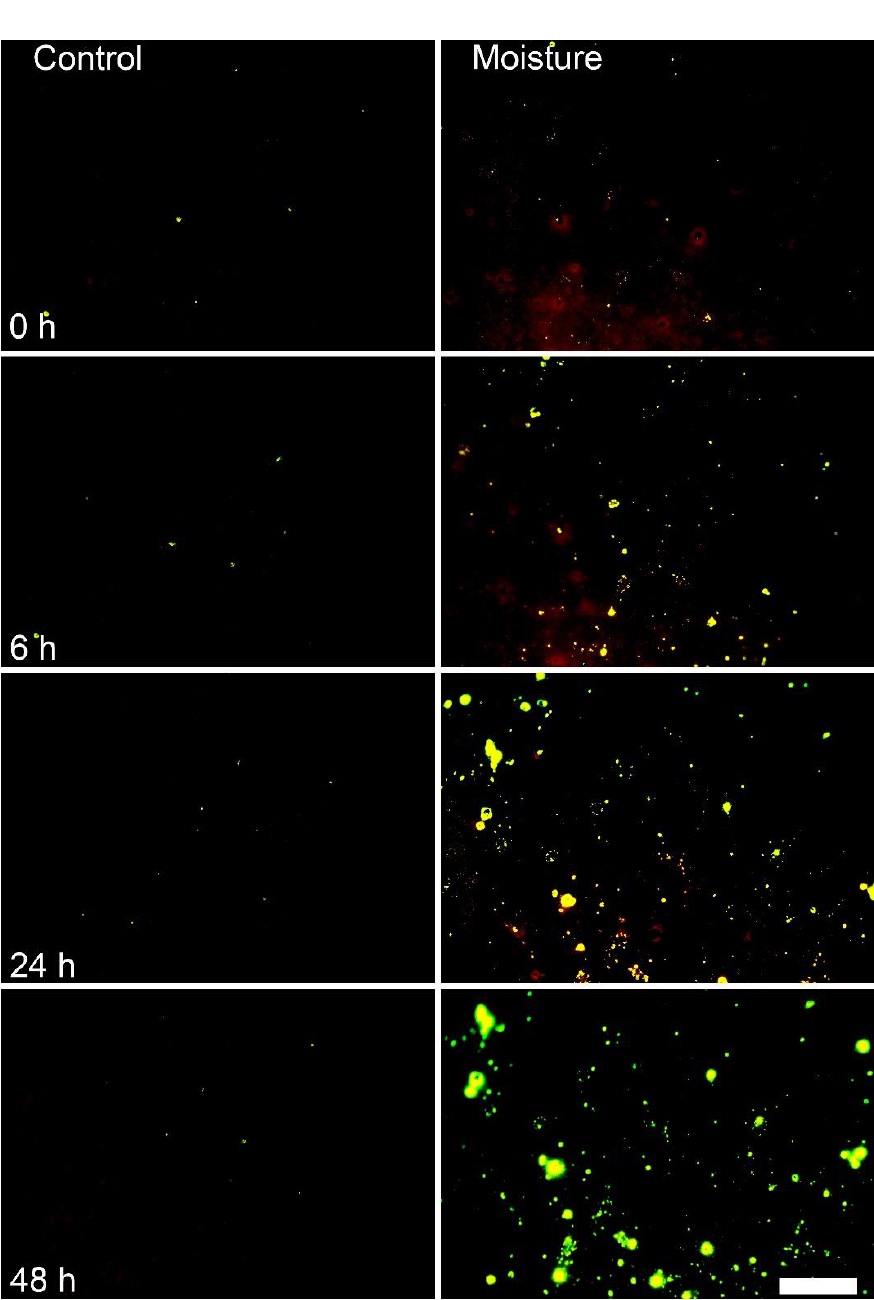
Figure 1. Effect of moisture exposure of the surface of fruit of mango cv. apple on microcracking of the cuticle. The fruit surface was exposed to surface moisture for 0, 6, 24 or 48 h. An untreated surface remained dry and served as the ‘control’. Microcracking was visualized by infiltration with aqueous acridine orange. N = 10. Scale bar 1 mm.